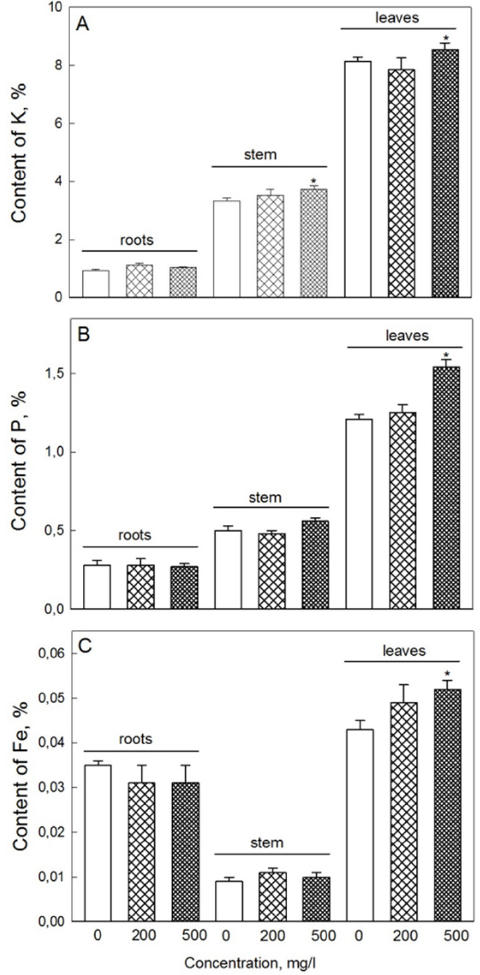
Figure 7. Elemental composition (amount of potassium ( A ), phosphorus ( B ), and iron ( C ) per dry weight basis) in roots, stems, and leaves of 19-day-old wheat plants treated with various concentra- tions of Fe 3 O 4 NPs. Data are means ± SD ( n = 4). Data labelled with asterisks is significantly different from appropriate controls at p < 0.05.